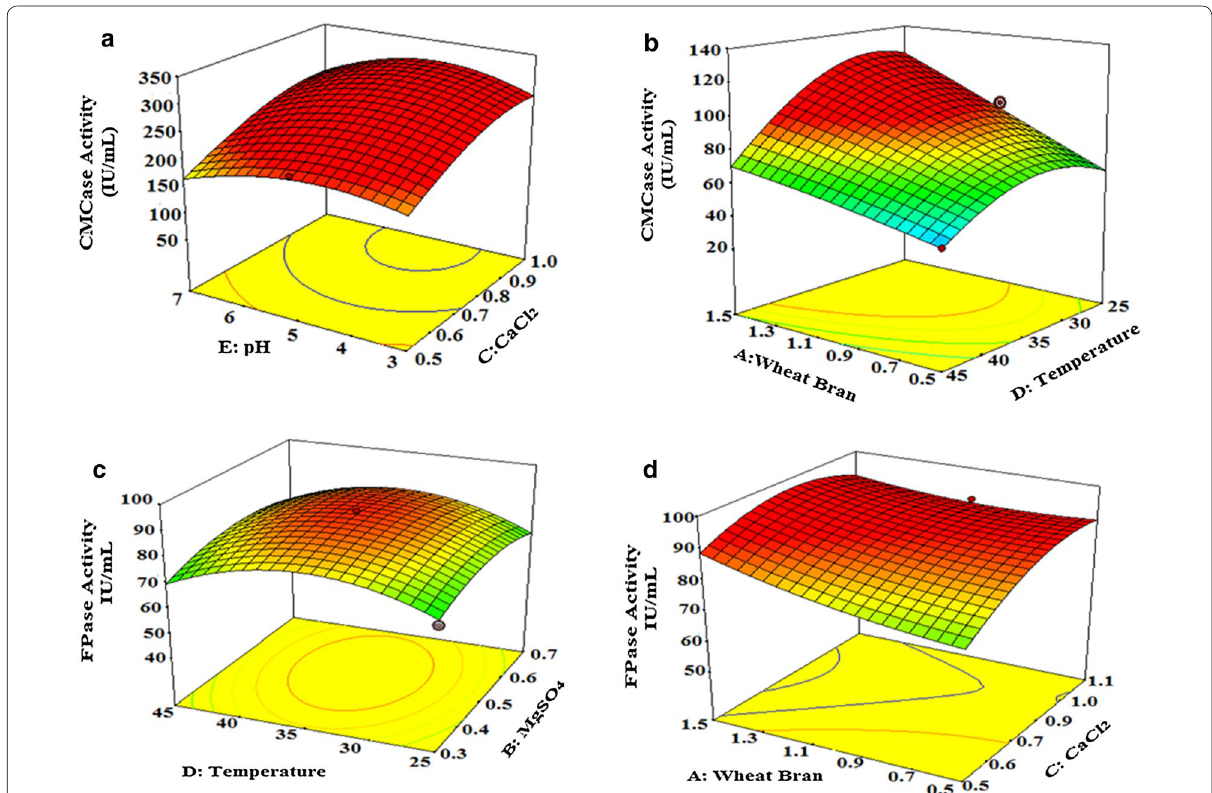
Fig. 2 Response surface plot and contour plot for CMCase and FPase production from Schizophyllum commune NAIMCC-F-03379 showing interaction between different variable: For CMCase activity a pH and calcium chloride, b wheat bran and temperature; For FPase activity c temperature and magnesium sulphate, d wheat bran and calcium